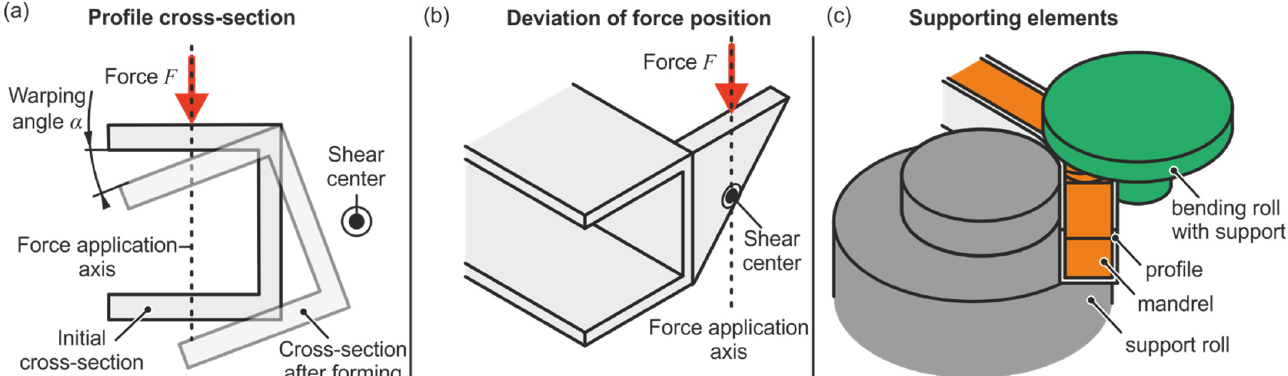
Figure 1. Countermeasures to reduce warping in profile bending profiles for the example of a U-profile. ( a ) profile cross- section with the shear center as cause for warping, ( b ) countermeasure: moving the position of force application by altering the profile geometry. ( c ) countermeasure: use of supporting elements.